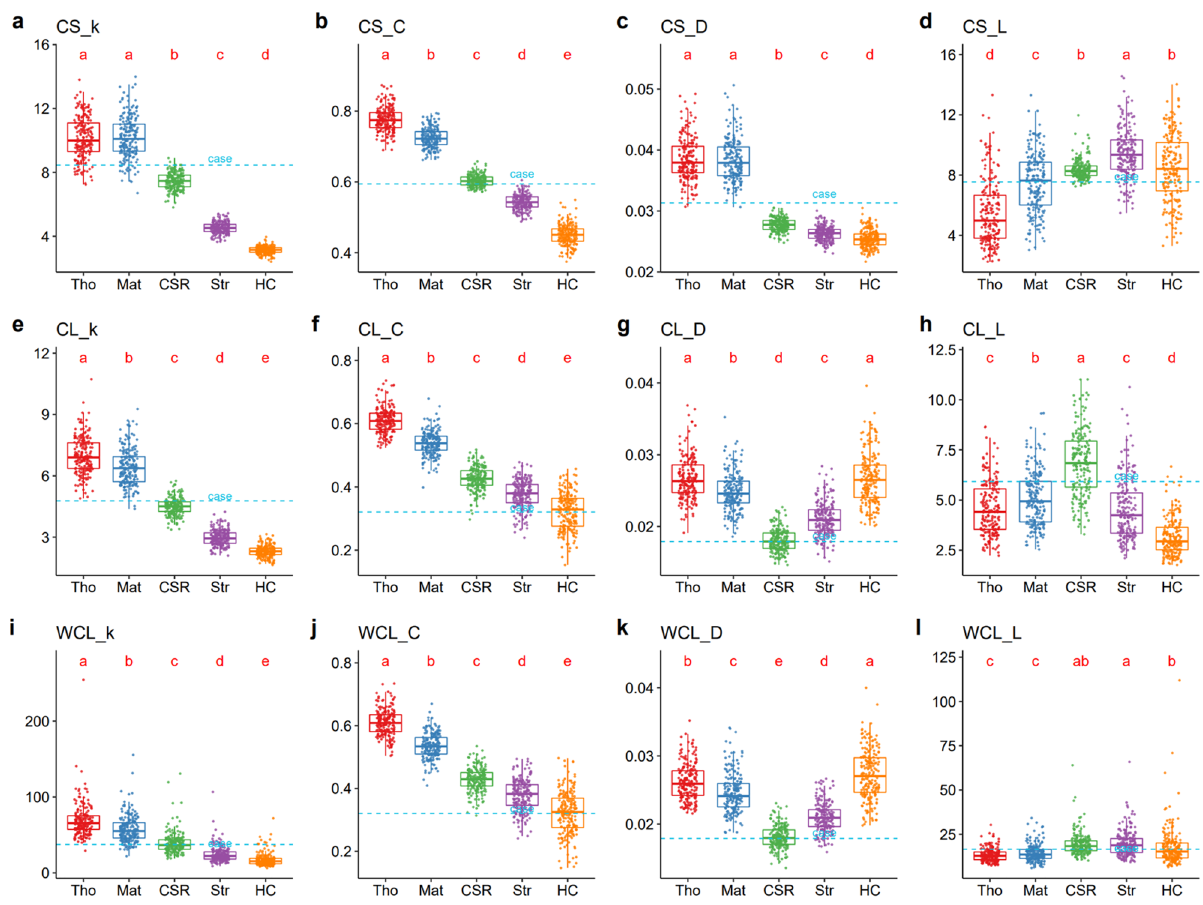
Figure 7. The basic characteristics of three types of networks (with individual trees as nodes) estimated on the forested swamp plot FS-1 in Costa Rica (represented by the horizontal blue line). Simulated metrics are generated based on five spatial null models ( CSR complete spatial randomness, Mat Matérn process, Tho Thomas process, HC Gibbs hard core process, Str Strauss process) with parameters estimated on the dataset to be comparable. Values of each metric (the average node degree k, the clustering coefficient C , the density D , and the average path length L ) are generated by 199 Monte-Carlo simulations. Differences among five models were examined by ANOVA, followed by Tukey multiple comparisons tests (for more details, see Supplementary Table S2). In WCL, the weighted average node degree k was calculated, while values of C , D , and L are consistent with that of CL because edge weights are not used when calculating these